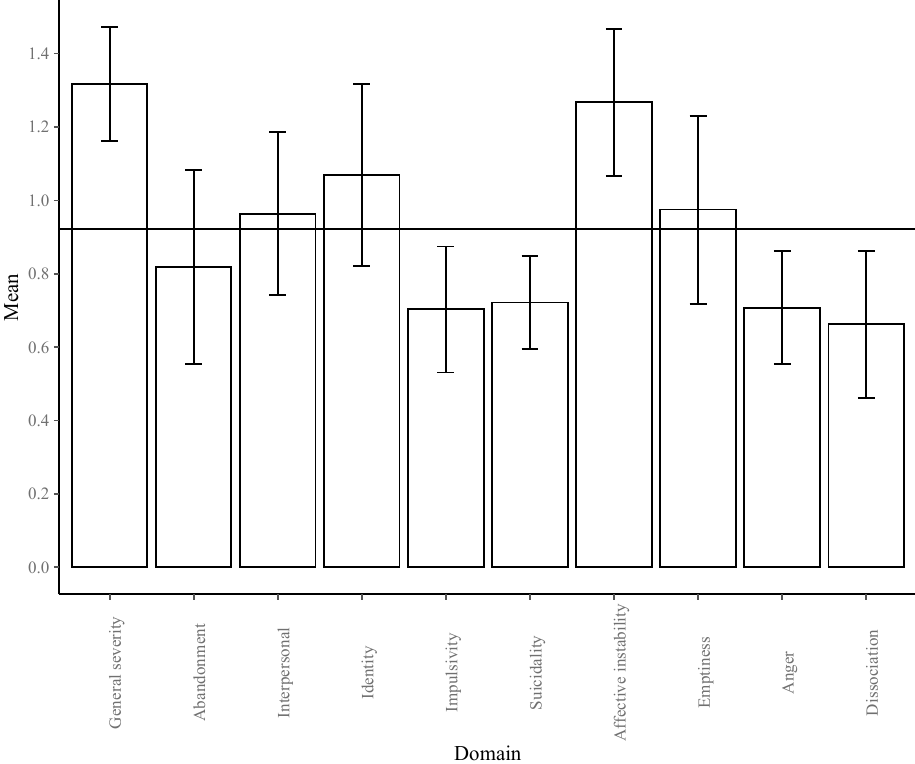
Figure 3. Bar graph of the estimated marginal means of the transformed effect sizes based on the log of time, estimated at one year of treatment for all BPD domains, with 95% CIs. The grand mean is depicted as a horizontal line at g = 0.921.